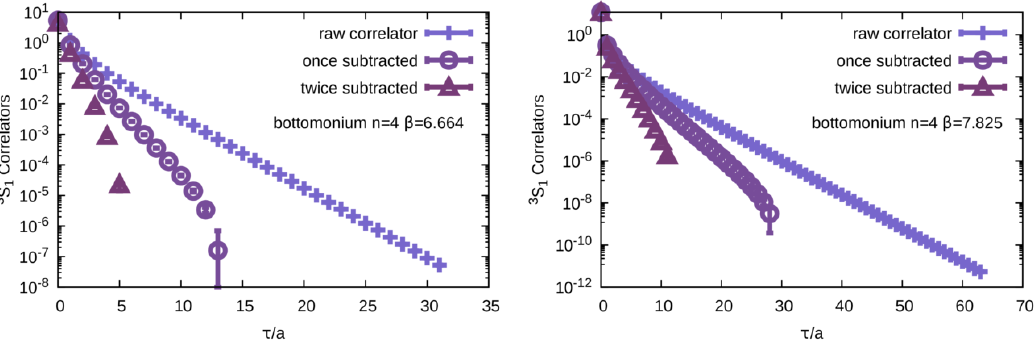
Figure 12 . Representative examples of the raw S-wave bottomonium correlator (light blue crosses), as well as after subtraction of the ground state contribution (open circle) and after further subtract- ing the (cid:12)rst excited state contribution. Note that both at (cid:12) = 6 : 664 with N (cid:28) = 32 (left) and even at (cid:12) = 7 : 825 with N (cid:28) = 64 (right) only a very small number of convex points remain to encode the UV regime including the continuum